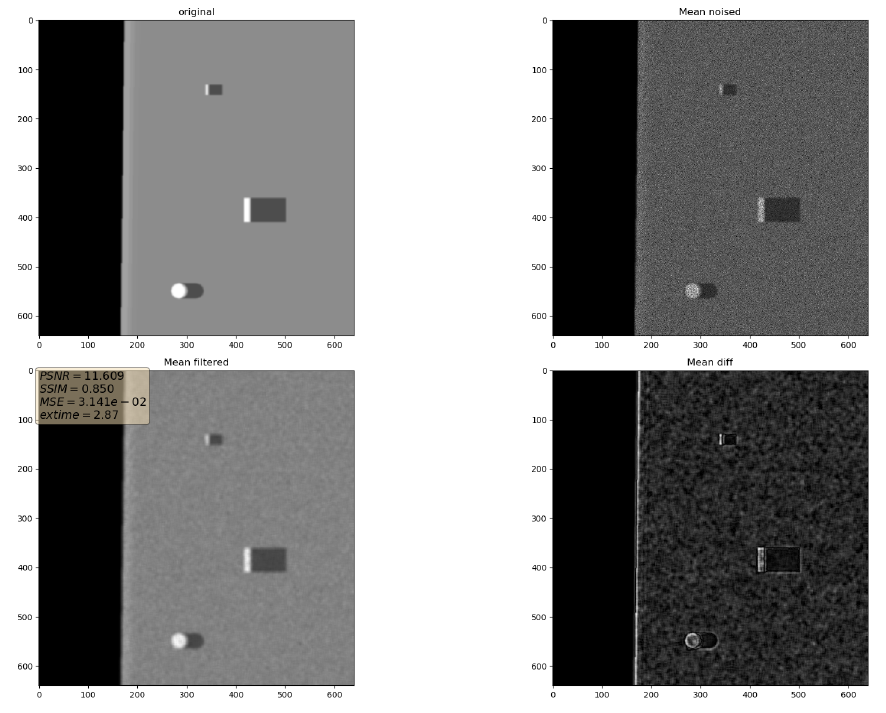
Figure 8. Filtering results for Mean filter. Speckle noise σ 2 = 0.05.